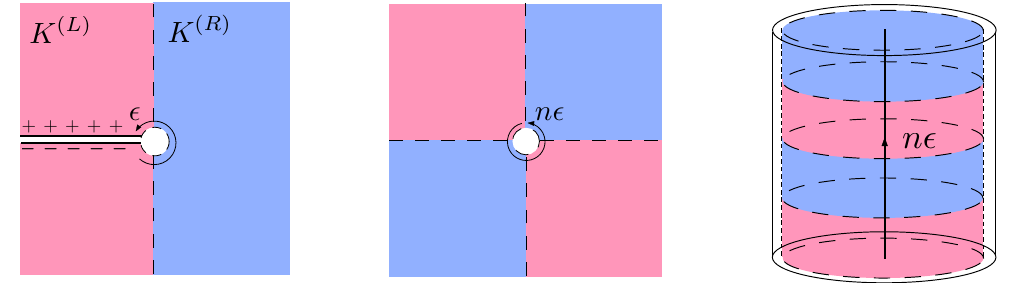
Figure 5 . (Left) A cartoon of the reduced density matrix after tracing out the K ( R ) phase. Regions with level matrix K ( L ) are denoted by pink shading in this and all other (cid:12)gures, and regions with level matrix K ( R ) are denoted by blue shading. The introduction of the regulator results in a \keyhole" region in the reduced density matrix. (Middle) Tr(^ (cid:26) n ) is obtained by gluing n copies of the (cid:12)rst (cid:12)gure together cyclically. The (cid:12)gure represents this pictorially for n = 2. In these illustrations, a transverse dimension, which can be interpreted as Euclidean time, has been suppressed. (Right) This construction is conformally equivalent to a path integral on S 1 which can also be viewed as a solid torus. Top and bottom of this sub(cid:12)gure are identi(cid:12)ed.